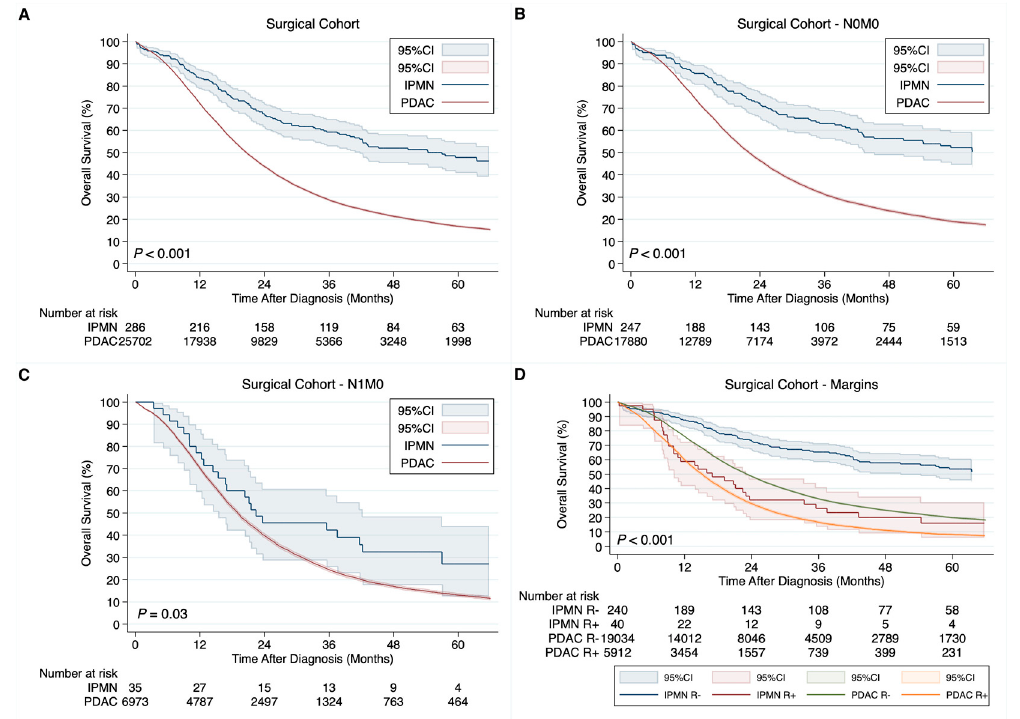
Figure 3. Kaplan–Meier curves demonstrating differences in overall survival in the surgical cohort for invasive pancreatic ductal adenocarcinoma (PDAC) vs. invasive intraductal papillary mucinous neoplasm (IPMN) overall ( A ), in the subgroup of N0M0 disease ( B ), in the subgroup of N1M0 disease ( C ), and by resection margin status ( D ).